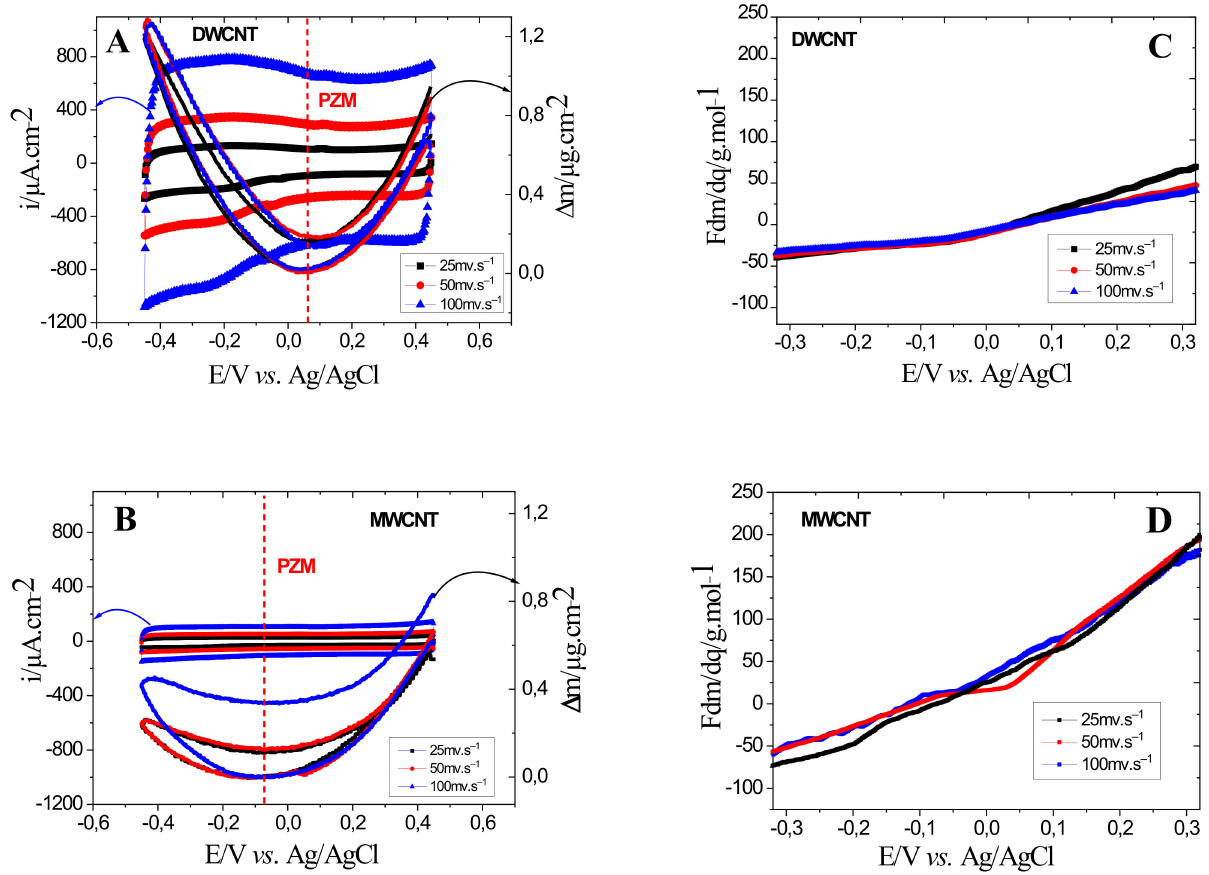
Figure 3. EQCM results of DWCNT ( A ), and MWCNT ( B ) measured in a 0.5 M NaCl aqueous electrolyte. The average molecular weight values of the species involved in the electrochemical process showed as a function of the potential obtained from the reduction branch of EQCM data are presented in ( C , D